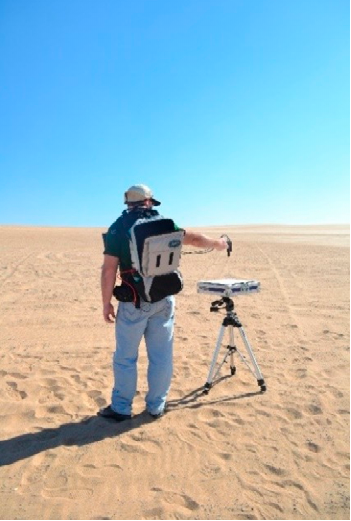
Figure 3. Spectralon panel measurements collection.